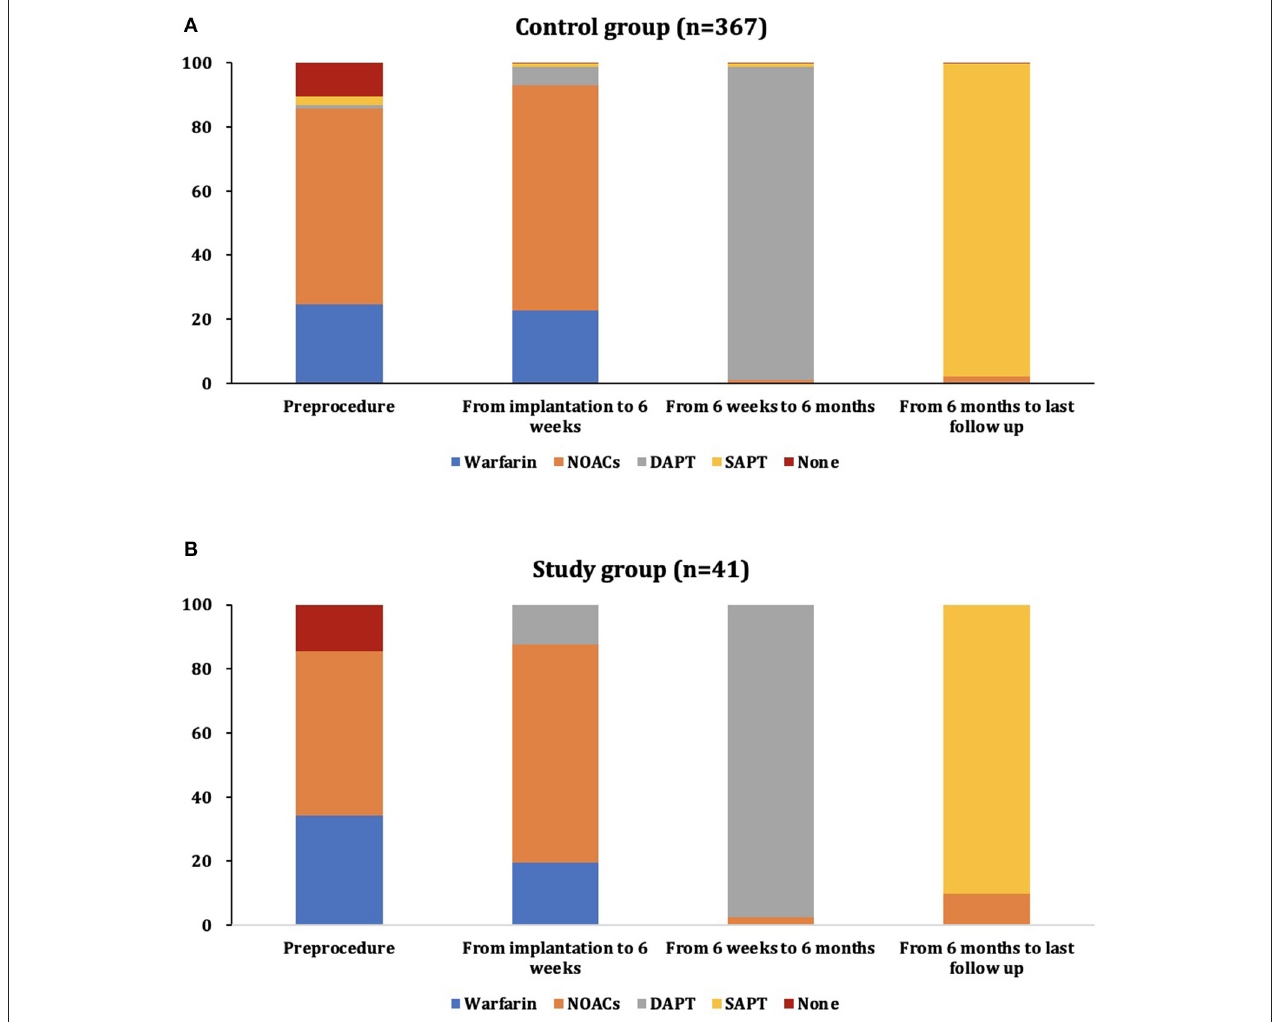
FIGURE 2 | The distribution of antithrombotic therapy during different periods of follow-up in the control group (A) and study group (B) . DAPT, dual antiplatelet therapy; NOAC, non-vitamin K antagonist oral anticoagulant; SAPT, single antiplatelet